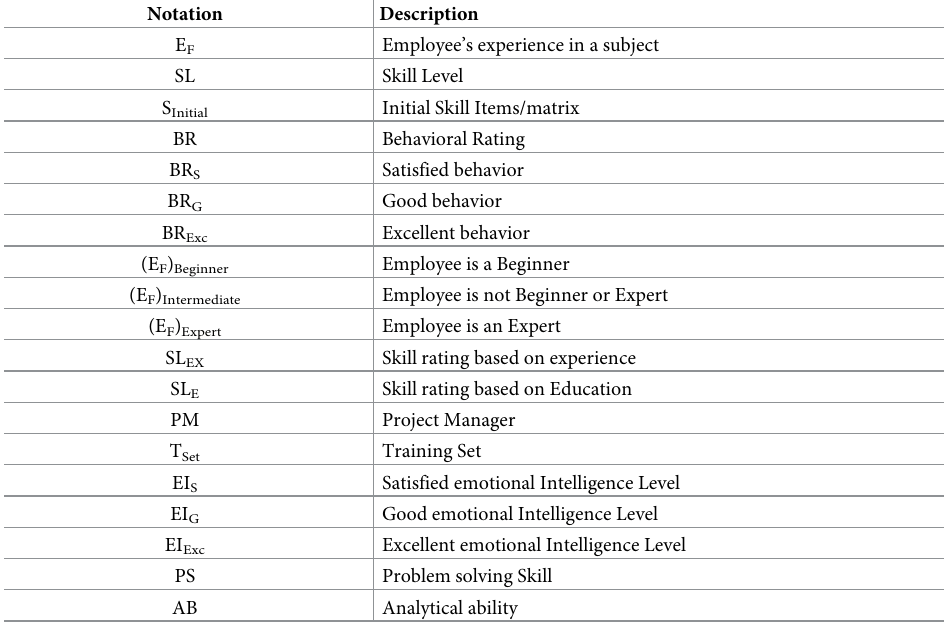
Table 2. Algorithm symbols